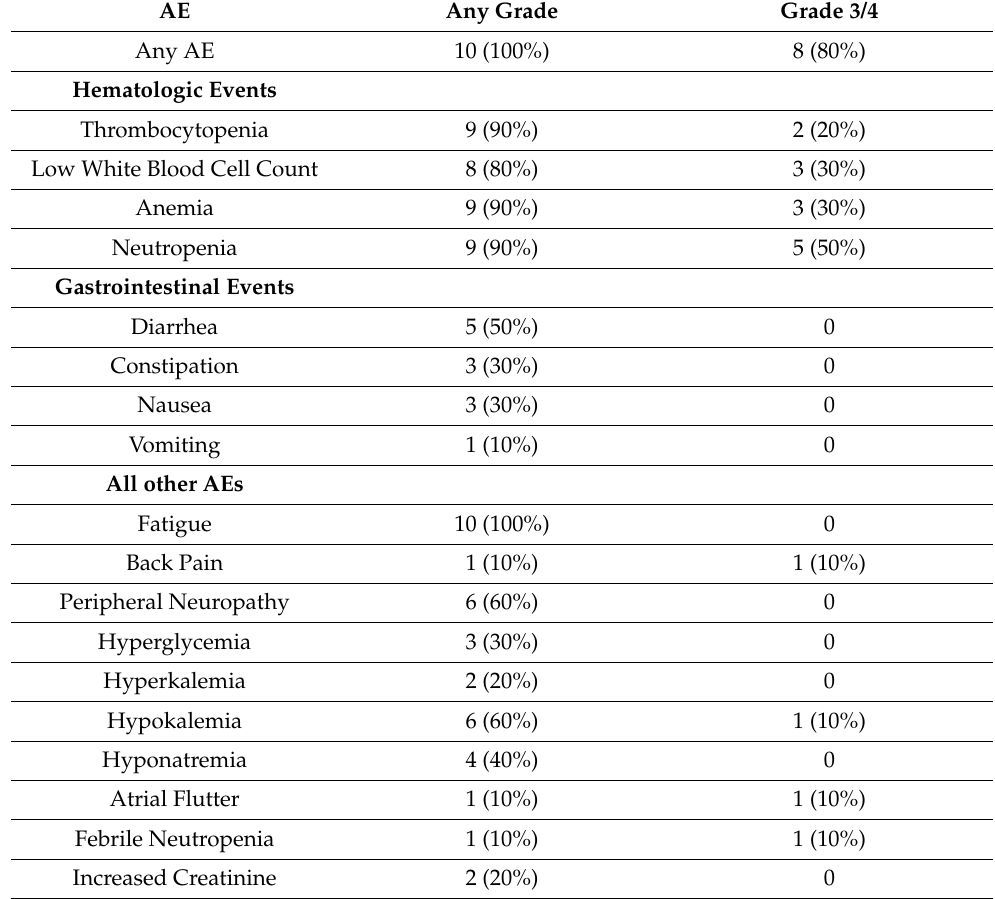
Table 2. Treatment-Emergent Adverse Events ( n =